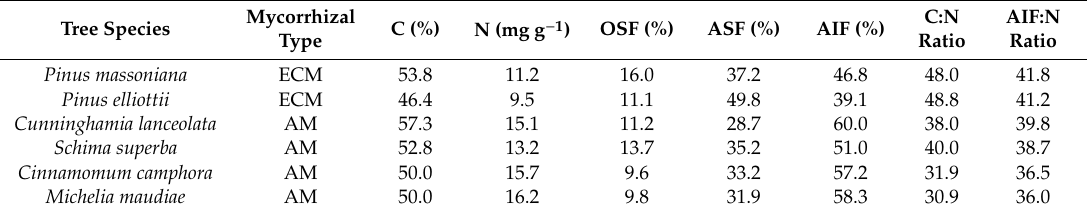
Table 1. Mycorrhizal types and initial root litter chemical traits of the studied six tree species. ECM, ectomycorrhizal; AM, arbuscular mycorrhizal; OSF, organic soluble fraction; ASF, acid soluble fraction; AIF, acid insoluble